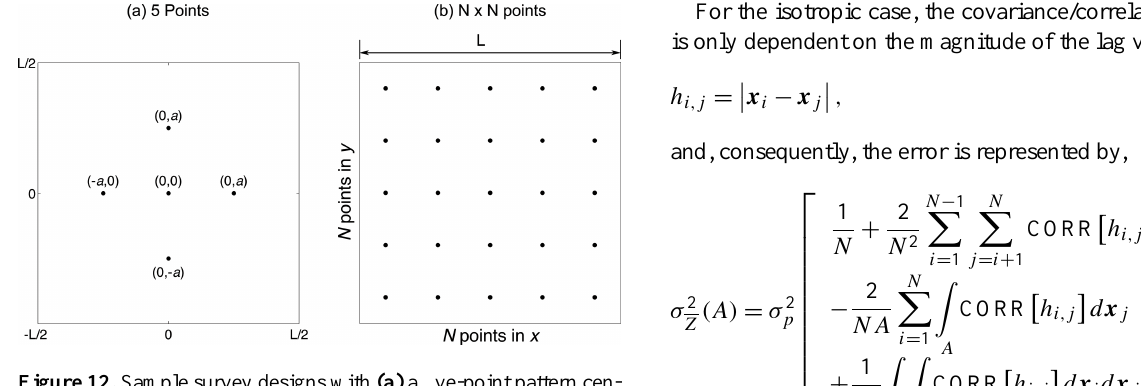
Figure 12. Sample survey designs with (a) a five-point pattern cen- tered in the area, and (b) a regularly spaced pattern. For the five- point pattern, a can vary between 0 and L/ 2, while for the N × N points pattern, the separation between the measurements is deter- mined by the number of